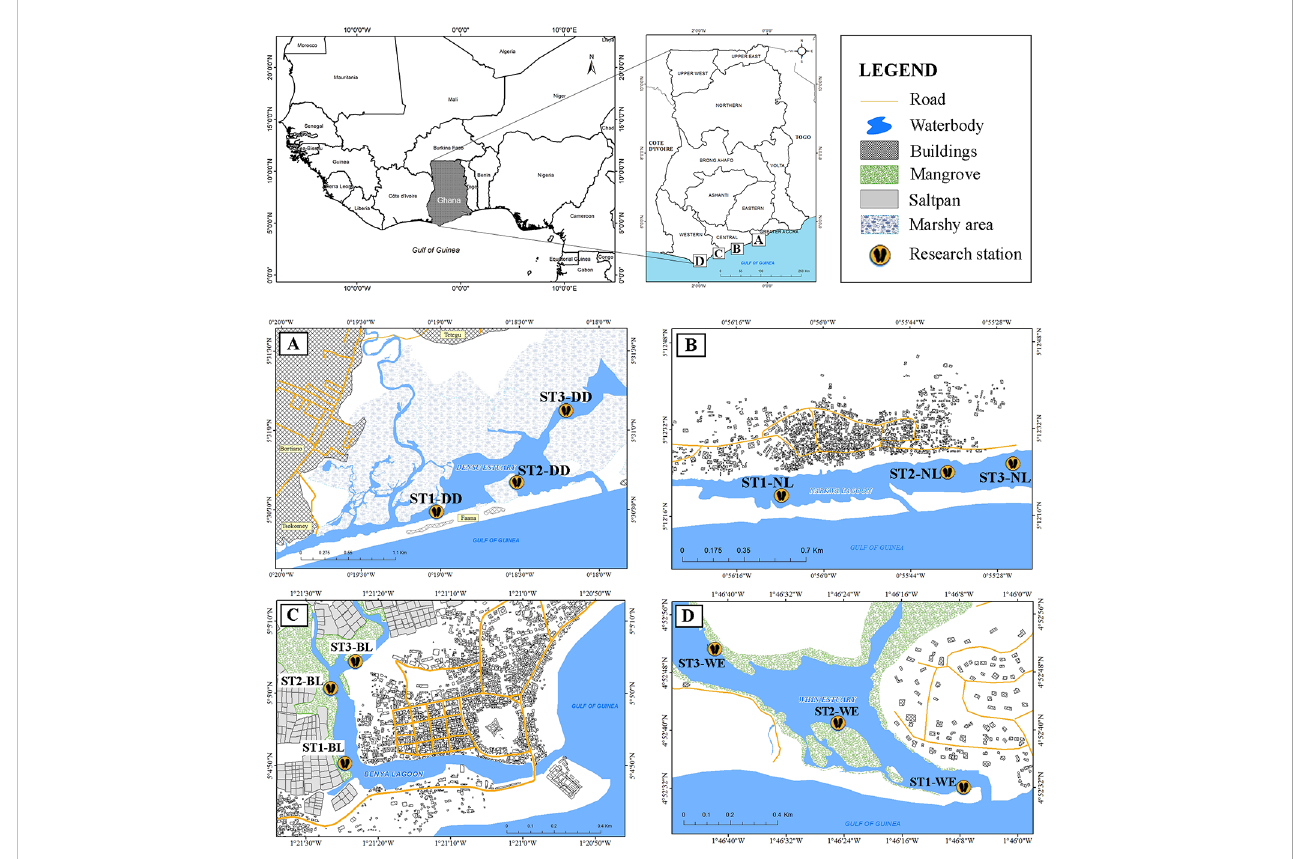
FIGURE 1 Maps of the water bodies with experimental stations (ST) indicated: (A) Densu Delta - DD, (B) Narkwa Lagoon - NL, (C) Benya Lagoon - BL, and (D) Whin Estuary - WE. Published fi rst in Chuku et al.